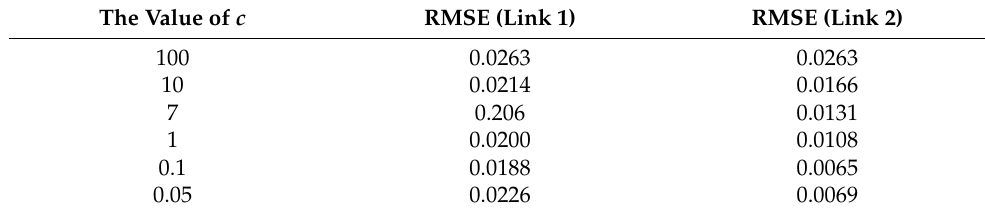
Table 3. RMSE results with different value of c .